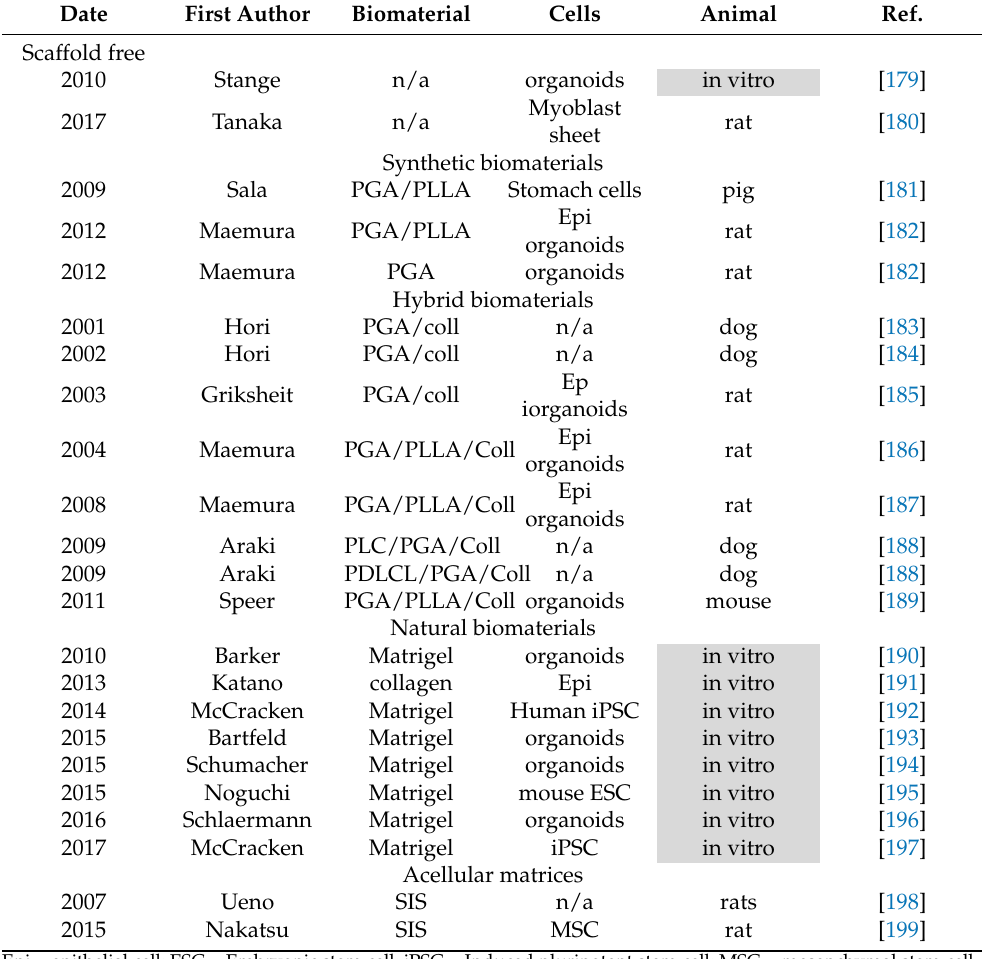
Table 4. Protocols for the reconstruction of stomach or stomach patches.